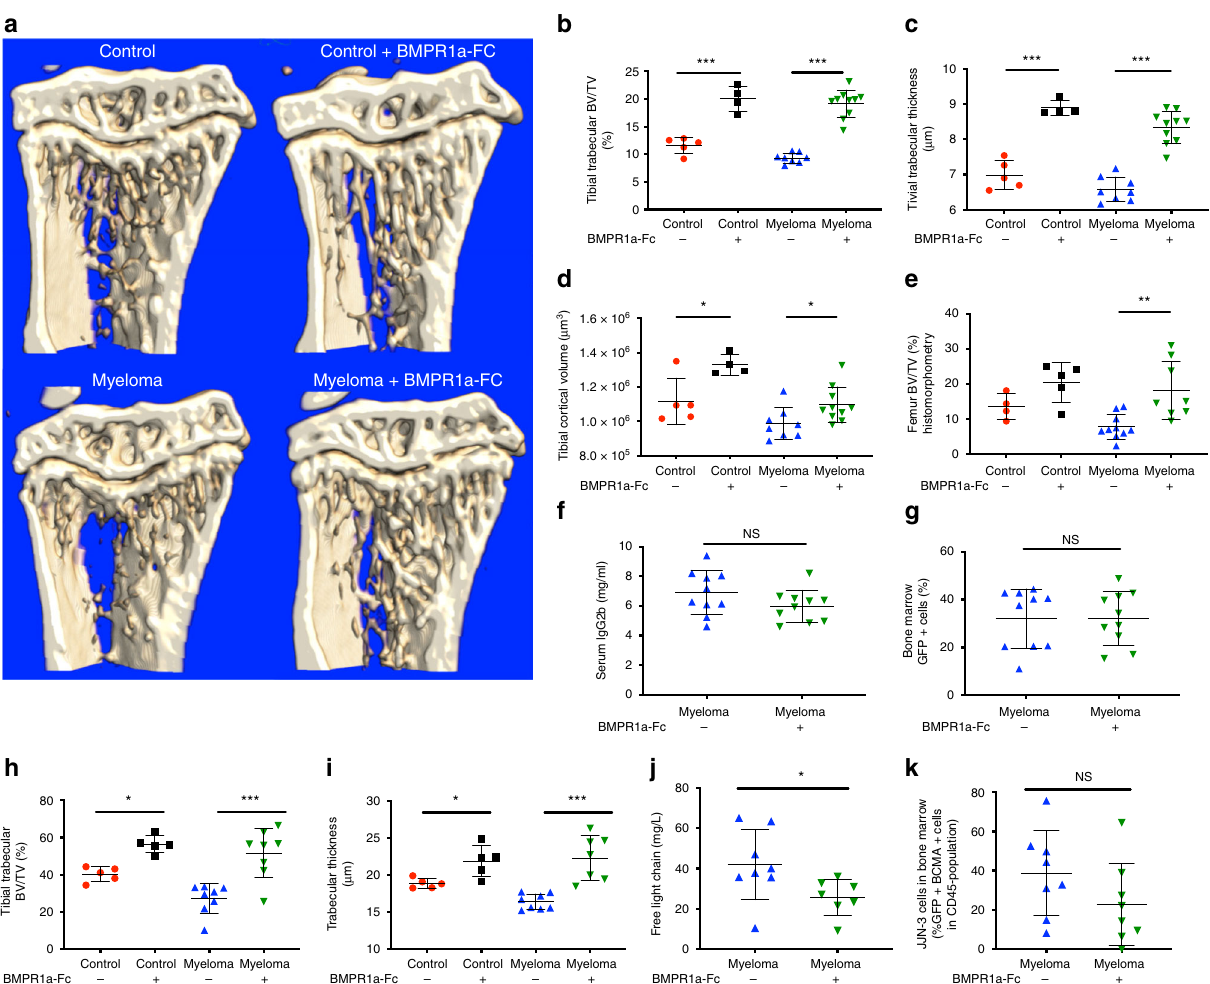
Fig. 3 Inhibition of BMP signalling with BMPR1a-FC reduces myeloma bone disease in vivo, with no effect on tumour burden (5TGM1 model; n = 5 per control group, 10 per myeloma group, total n = 30. JJN-3 model; n = 5 per control group, 8 per myeloma group, total n = 26). * P < 0.05, ** p < 0.01, *** p < 0.001, NS, not signi fi cant, t test. a Reconstructed microCT images of tibial sagittal sections showing trabecular architecture. Reconstructed tibial metaphyseal images analysed using Bruker CTAn software to generate b – d : b trabecular BV/TV (bone volume/total volume). c Trabecular thickness in μ m. d Cortical volume in μ m 3 . e Histomorphometric analysis of right femoral metaphysis sections using Osteomeasure software to generate BV/TV. f 5TGM1-GFP myeloma disease burden quanti fi cation using serum IgG2b level (mg/ml). g 5TGM1-GFP myeloma disease burden quanti fi cation using bone marrow GFP + percentage. h Trabecular BV/TV (bone volume/total volume) in JJN-3 model. i Trabecular thickness in μ m in JJN-3 model. j JJN-3 myeloma disease burden quanti fi cation using kappa free light chain quanti fi cation (mg/l). k JJN-3 bone marrow tumour burden was calculated by the sum of GFP + and human BCMA + cells as a proportion of murine CD45-negative population. Data represent mean ±